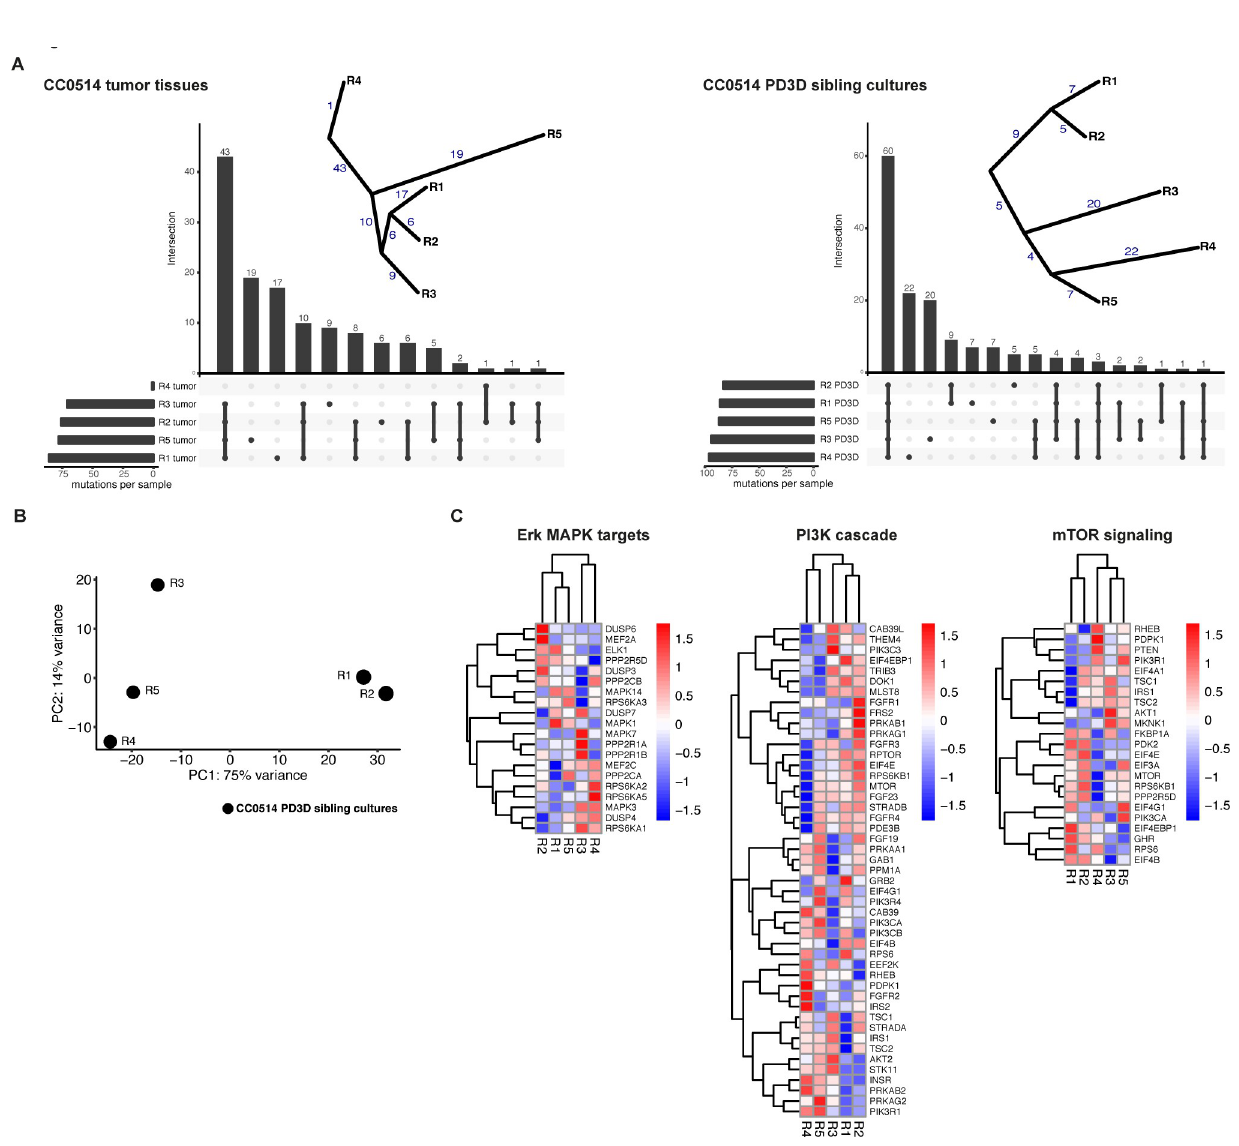
Fig 6. Tumor tissues and sibling cultures of patient CC0514 display genetic heterogeneity and heterogeneous mRNA expression profiles. Heterogeneity of tumor tissues and PD3D sibling cultures was evaluated on DNA and mRNA levels. (A) On the genomic level, somatic mutations were called from DNA of the five original tumor pieces (R1-R5) of the primary tumor of patient CC0514 and the respective PD3D sibling cultures, compared to CC0514 patient´s blood. Cellular content of tumor tissue R4 was very low. UpSet plots show rare somatic mutations (MAF < 0.001) in exonic regions used to construct evolutionary trees of the somatic mutations, displayed next to the plots. The numbers of shared or private mutations are given. (B) Principal Component Analysis of the mRNA expression of the sibling cultures. First component on x-axis contains 75% of the variance and classifies the samples into two major groups R1/R2 vs. R3/R4/R5). (C) Heatmaps of mRNA expression of components of ERK/MAPK, PI3K and mTOR signaling pathways. Each row has been transformed using Z-score. The color code represents the scaled mRNA expression across samples. Genes and samples were hierarchically clustered using Euclidean